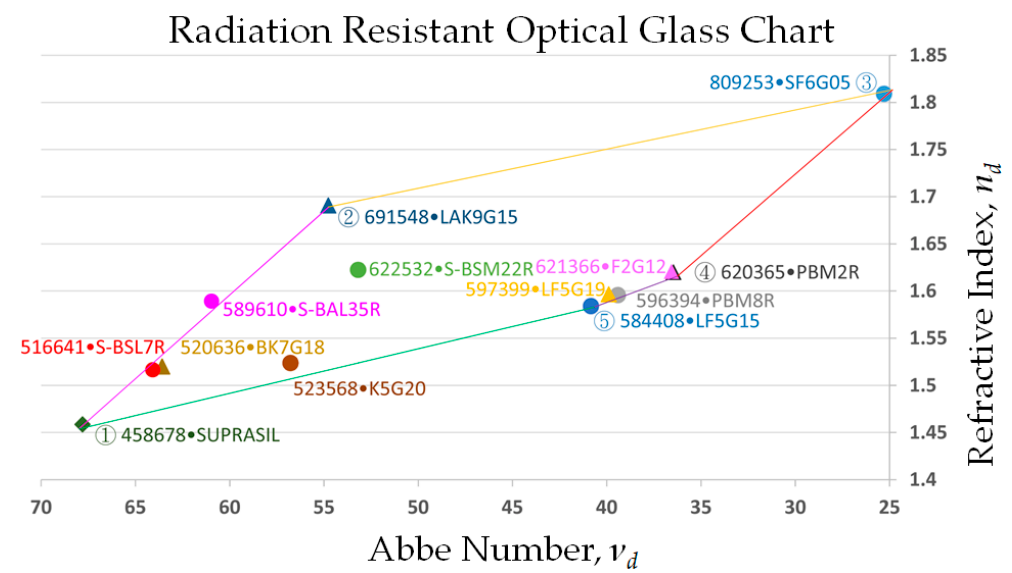
Figure 1. Radiation resistant optical glass materials.